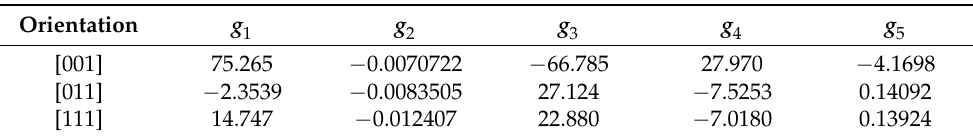
Table 7. DD6 material durable stress–life curve equation fitting parameter adapted from refer- ence